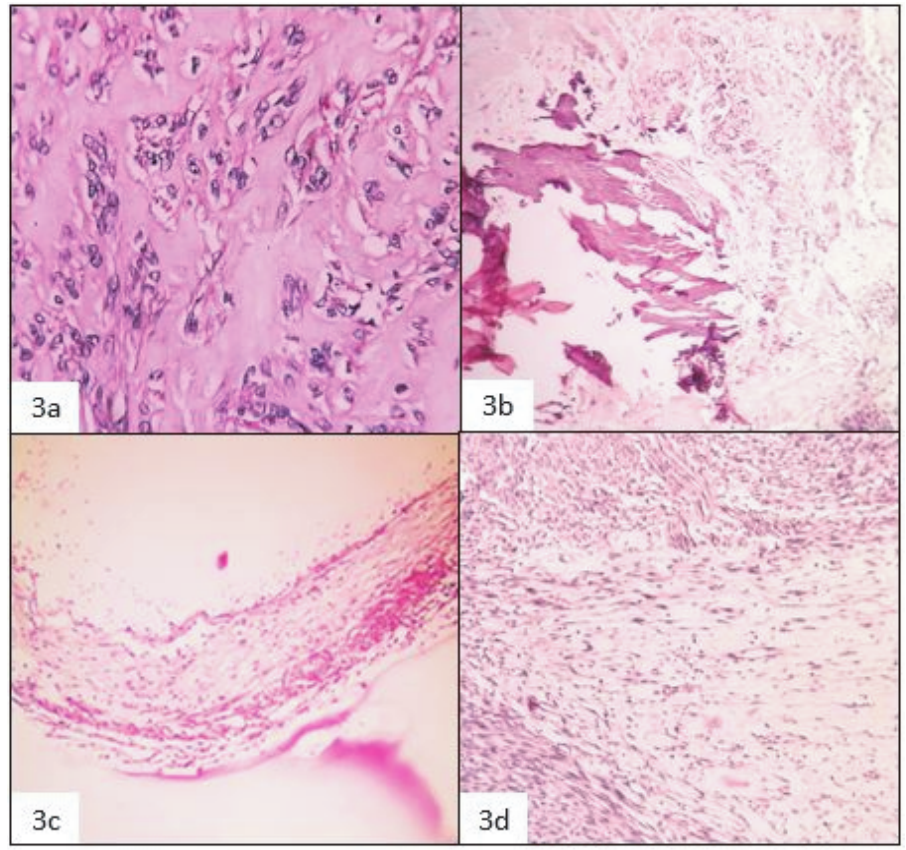
Figure 3 : Microscopic image of fibroids showing different types of degenerations (a – Hyaline change [H&E,￿ × 400], b – foci of calcifications [H&E, × 100], c – cystic change [H&E, × 400], d –myxoid change [H&E, ×